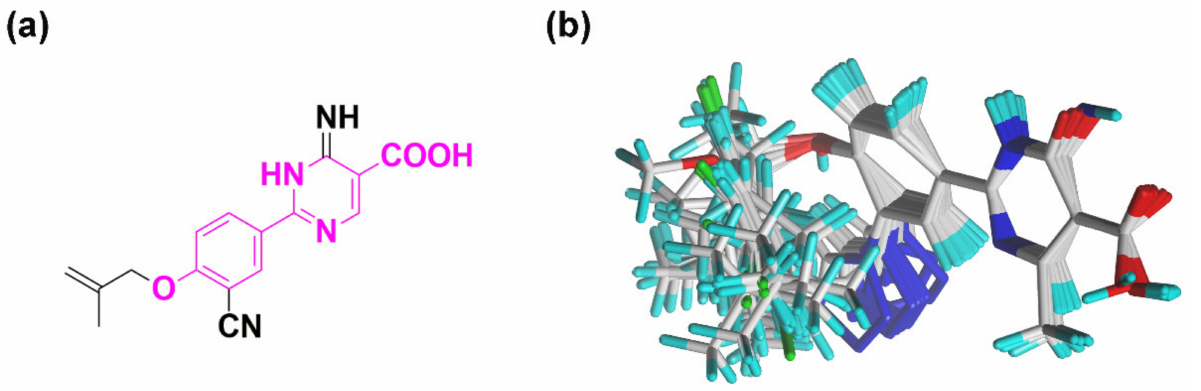
Figure 11. Molecular alignment for the 3D-QSAR models. ( a ) The common scaffold (magenta) used for the alignment. ( b ) The alignment result of all used